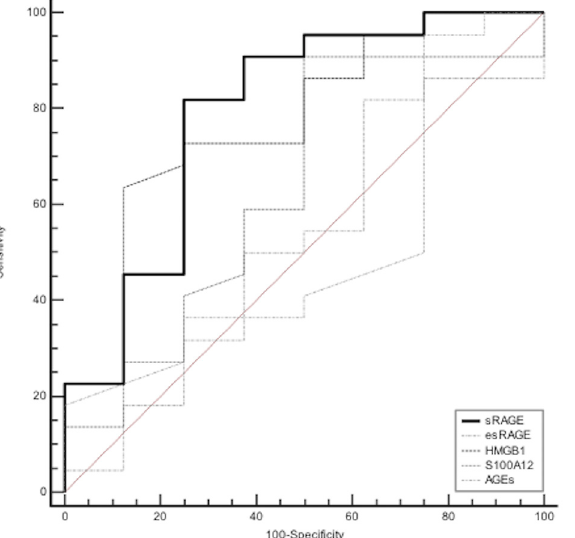
Fig 3. Receiver-operating characteristic curves of baseline arterial levels of sRAGE, esRAGE, HMGB1, S100A12 and esRAGE in differentiating between the presence and absence of nonfocal loss- of-aeration in computed tomography scan morphology studies on day 0 in patients with acute respiratory distress syndrome.